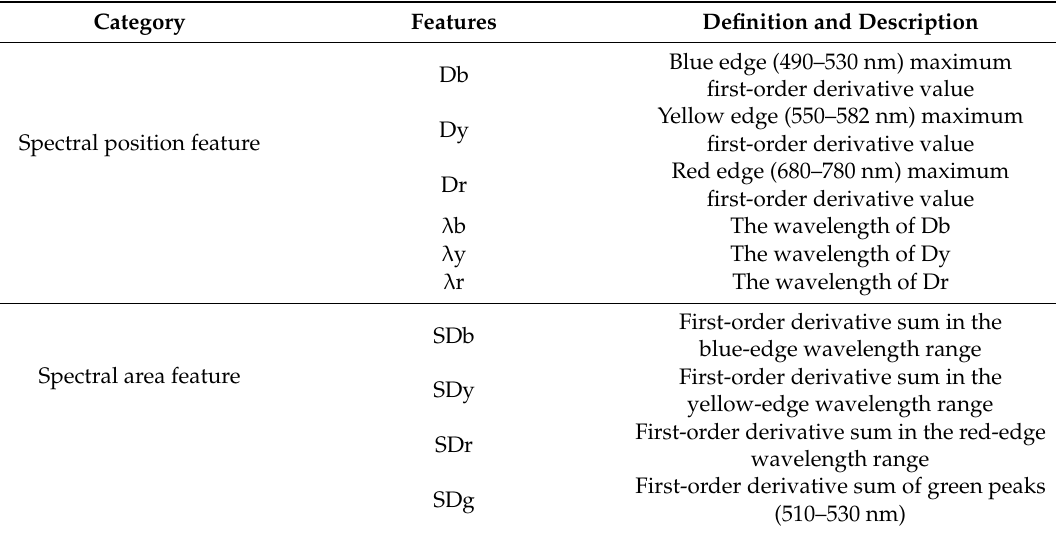
Table 2. Hyperspectral features based on first order